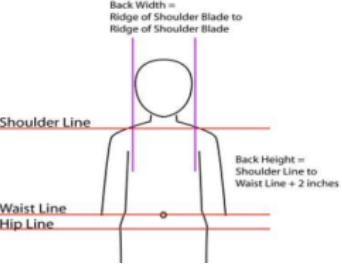
Figure 14. Fitting guide for a backpack (Source: Farideh Babakhani, The effect of backpack load on the posture of children [16])